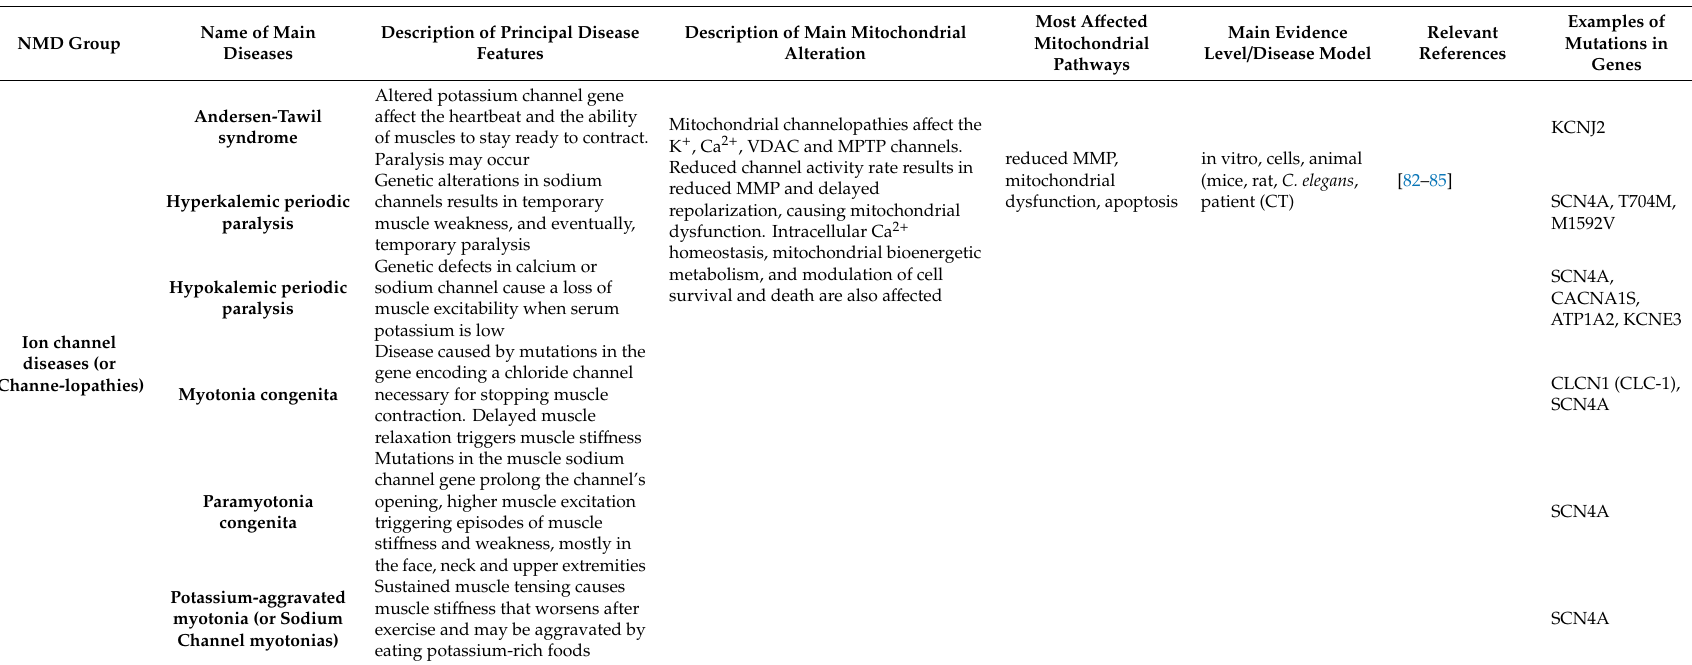
Table 5. Examples of studies reporting altered mitochondrial functions in ion channel